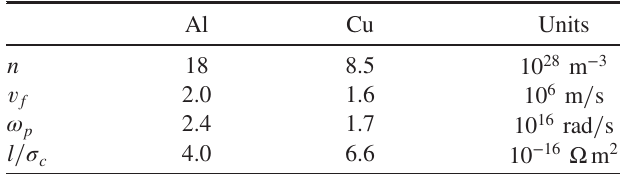
TABLE I. Free-electron Fermi gas model parameters for Al and Cu and constant l= σ c (used only for the extreme anomalous skin effect